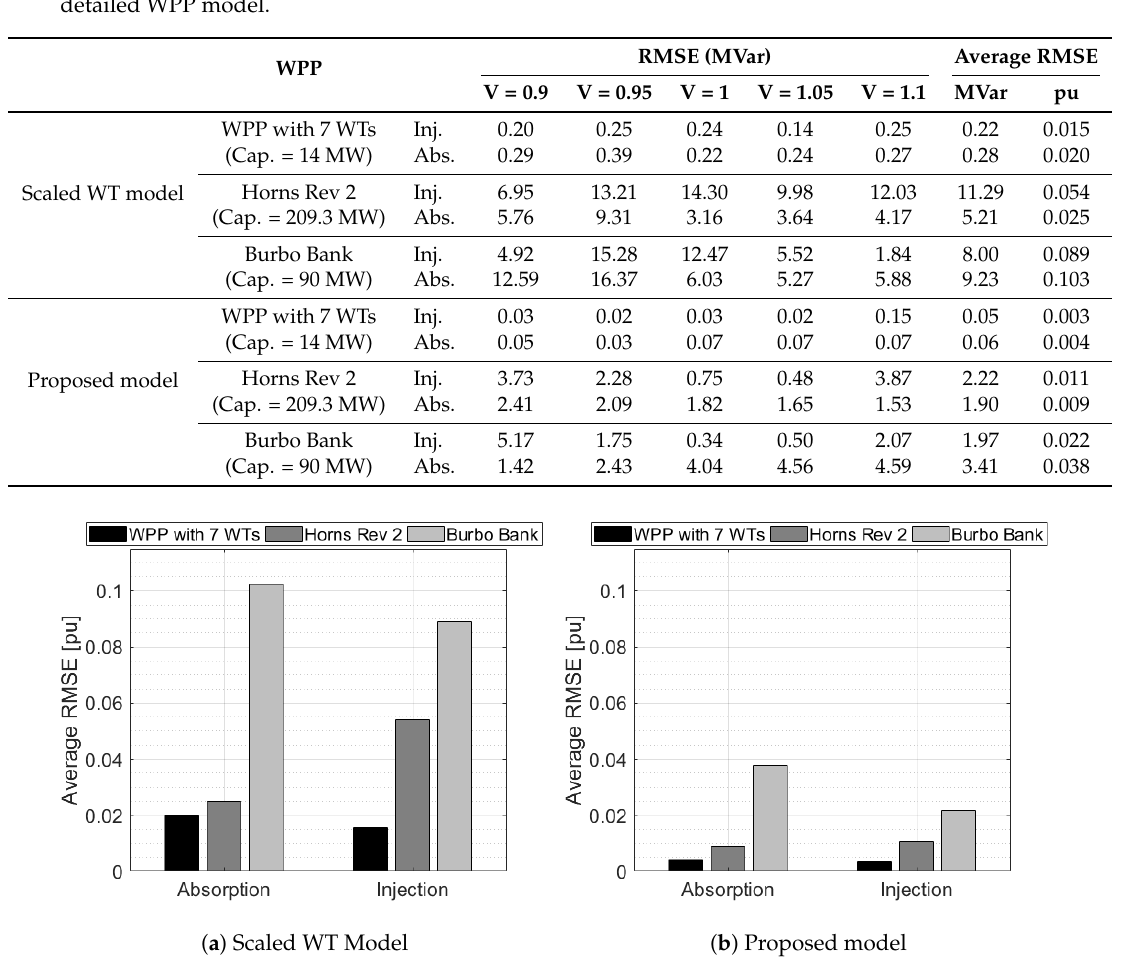
Figure 12. Average root mean square error (in percentage) when using scaled WT model and proposed WPP reactive power capability model as compared to detailed WPP